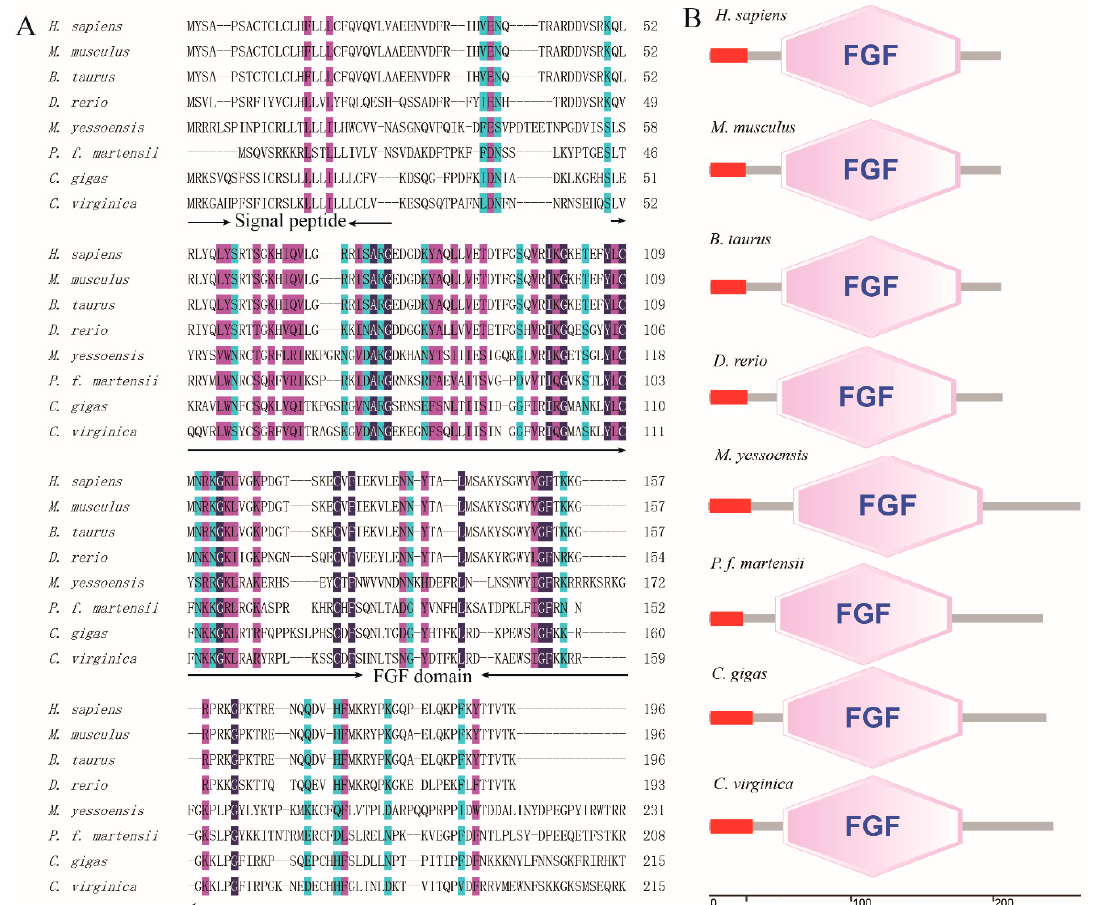
Figure 1. Multiple sequence alignment and structural organization of PmFGF18 amino acid sequence and other species. ( A ) shows the multiple sequence alignment of PmFGF18. Dark blue background indicates conserved aa; pink background indicates aa with strong similarity; light blue indicates aa with weak similarity. The numbers on the right present the total amino acid of each protein. ( B ) represents the structural organization of FGF18 among different species. The red region represents the signal peptide. Accession number for the sequences used in this alignment and domain analysis are as follows: C. gigas (XP_011453678.1), C. virginica (XP_022288219.1), M. yessoensis (OWF47747.1),